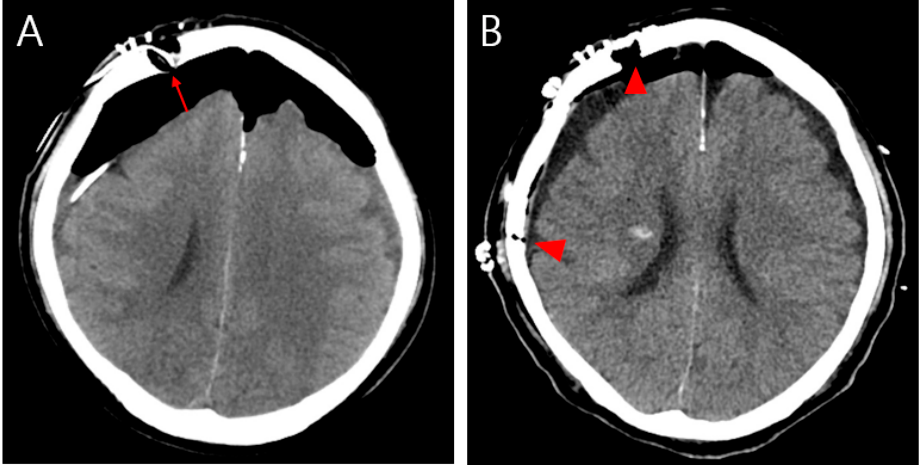
Figure 3. ( A ) Postoperative brain CT showing persistent intracranial air that compressed the brain parenchyma after burr hole trephination on the right frontal area (arrow). ( B ) After craniotomy, the CT image of the brain showed an improvement in pneumocephalus upon a reduction in the intra- cranial air (arrowhead).